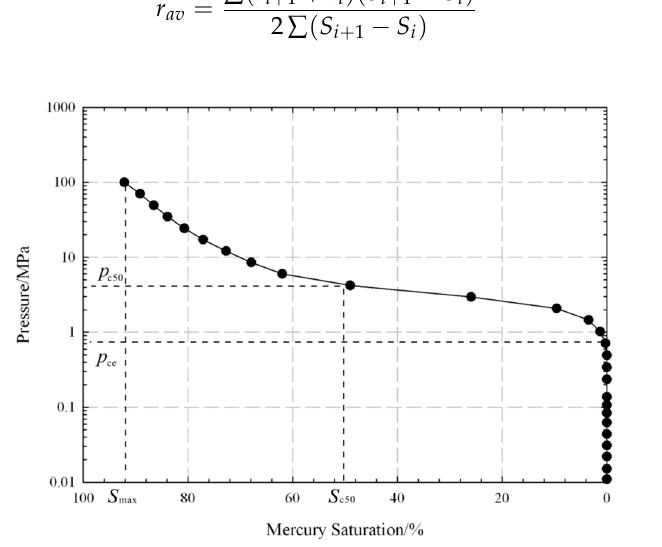
Figure 5. Capillary pressure curve of Sample #29.